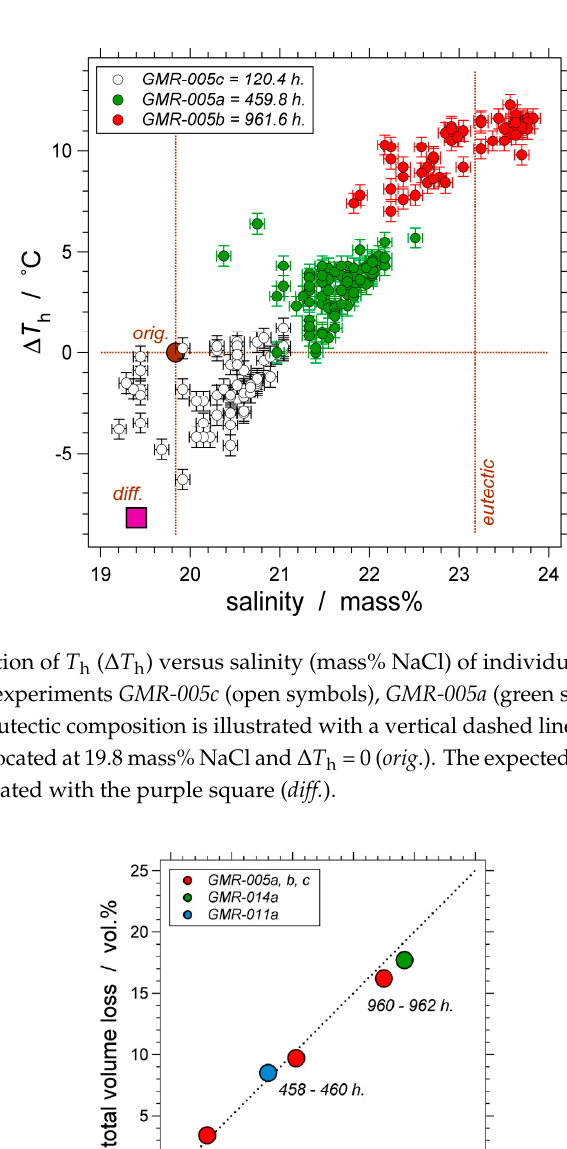
Figure 15. D 2 O composition versus fluid inclusion size (in µm 2 ), as observed from two-dimensional projections in microscope images after re-equilibration experiment GMR-009a (red symbols) and GMR-010a (green symbols).